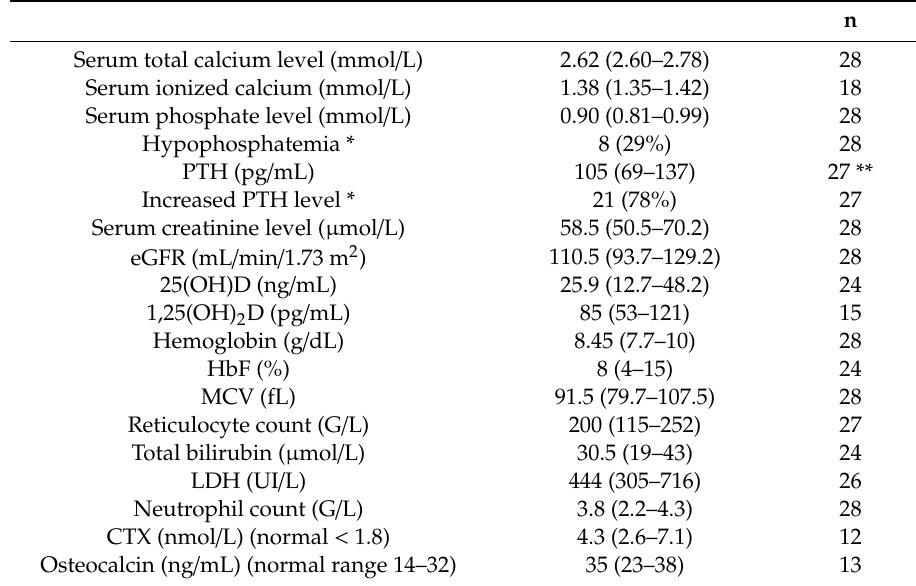
Table 2. Laboratory features of 28 adult patients with primary hyperparathyroidism and sickle cell disease at the time of pHPT